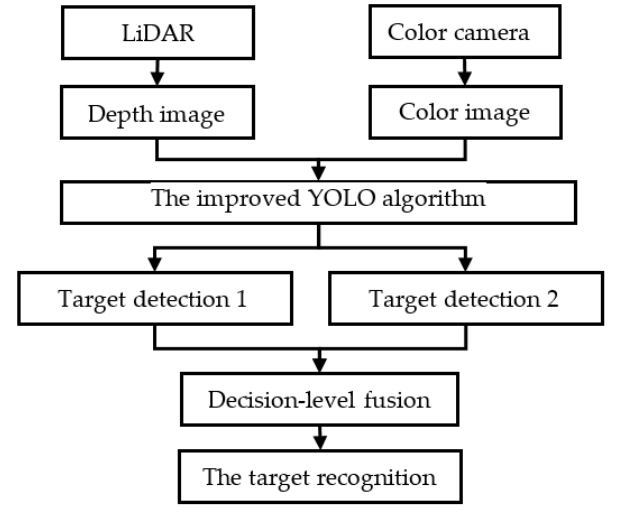
Figure 2. The flow chart of multi-modal target detection.